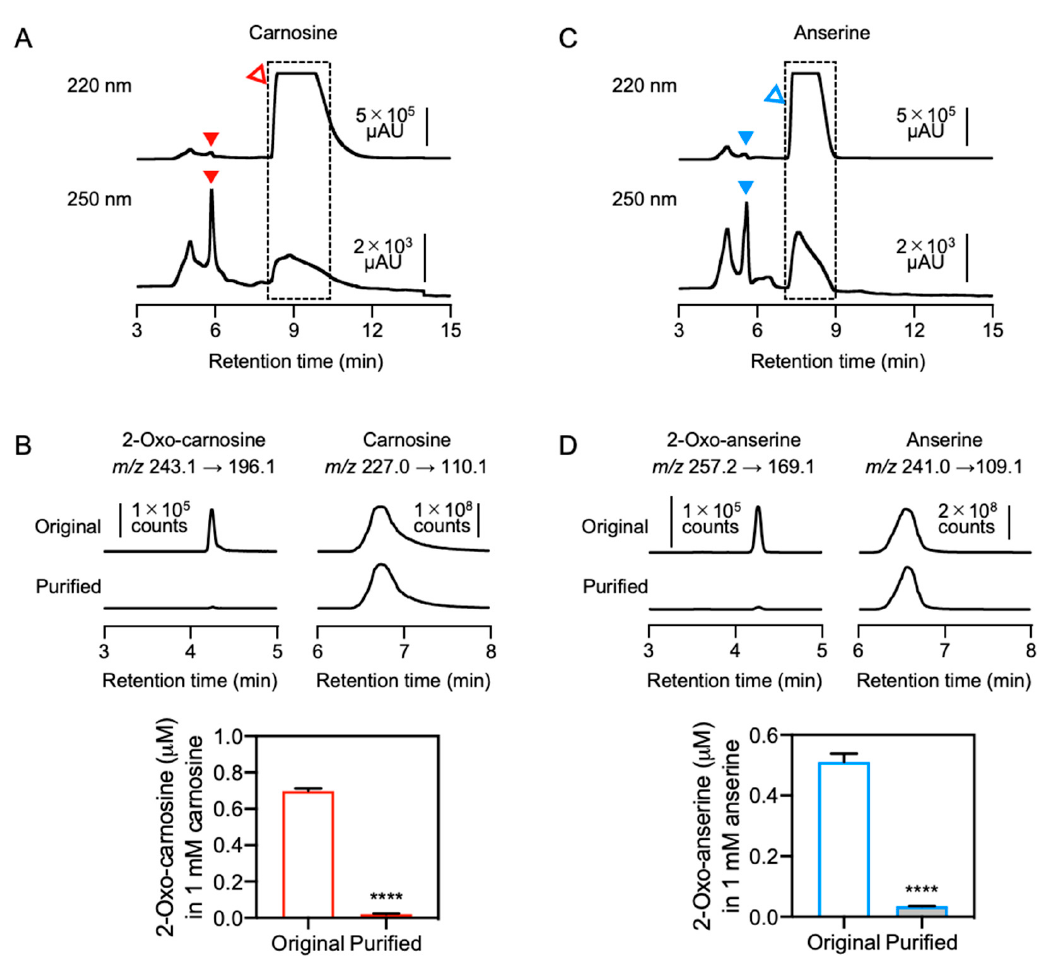
Figure 6. Preparation of purified IDPs. ( A , C ) Commercial carnosine and anserine standards were purified by HPLC. The fractions (dashed-line box) were recovered and were referred as “purified” samples. Open and filled triangles indicate IDPs (i.e., carnosine and anserine) and 2-oxo-IDPs (i.e., 2-oxo-carnosine and 2-oxo-anserine), respectively. ( B , D ) The concentrations of 2-oxo-carnosine or 2-oxo-anserine in 1 mM original or purified carnosine and anserine samples were analyzed by HPLC-ESI-MS/MS coupled with a stable isotope dilution method. Representative MS/MS chromatograms of 2-oxo-carnosine or 2-oxo-anserine (left), and carnosine or anserine (right) in the original or the purified carnosine and anserine samples. Data are presented as means ± SEM ( n = 3). **** p < 0.0001 versus the original sample, compared using unpaired Student’s t test.